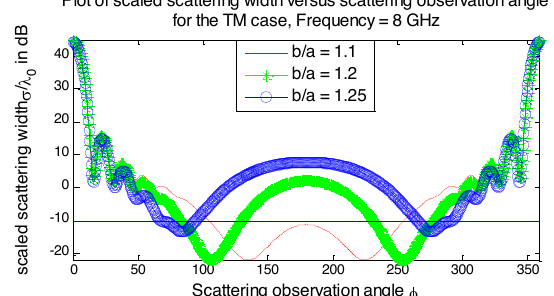
Plot of scaled scattering width versus scattering observation angle for the TM case, Frequency = 8